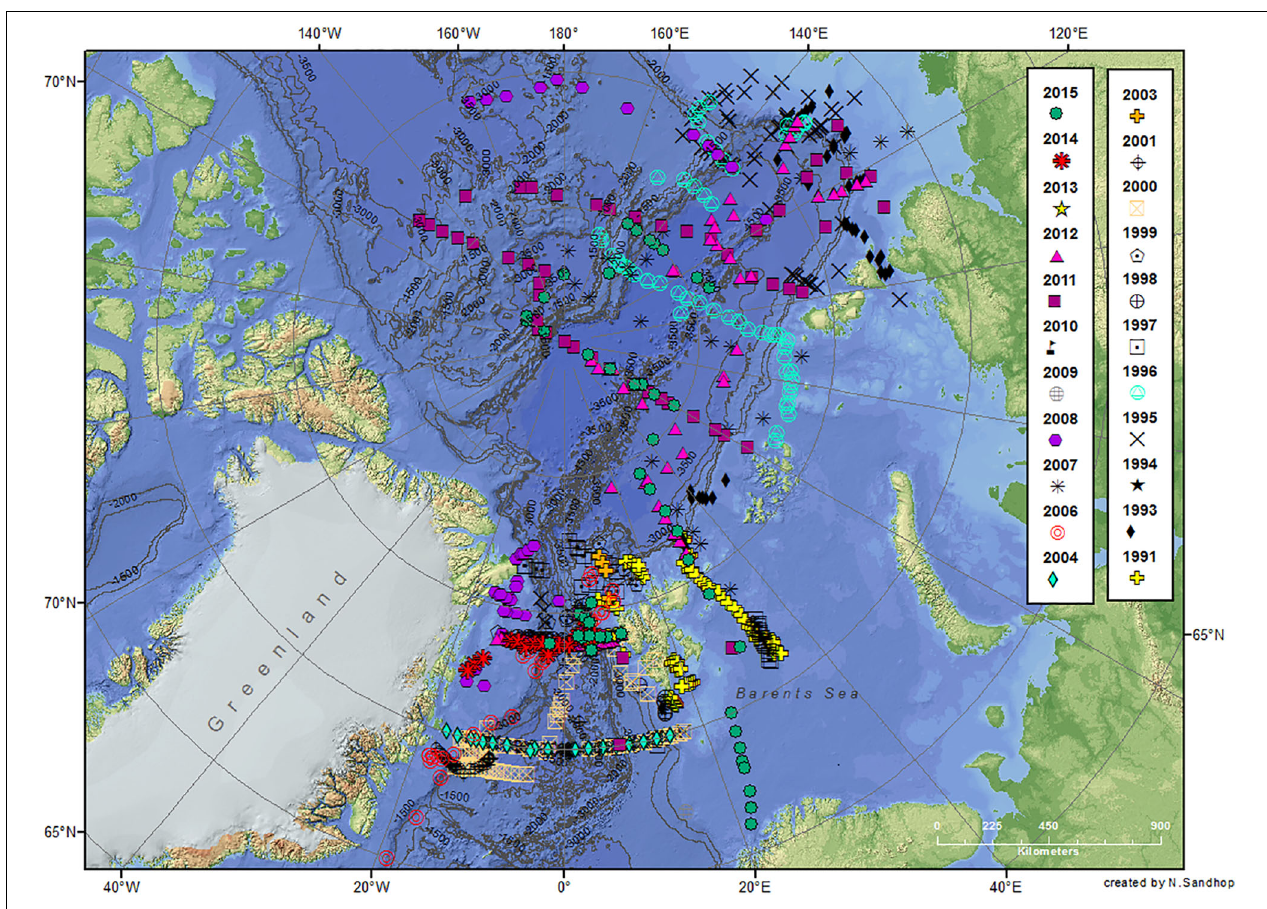
FIGURE 1 | Stations occupied during the different summer expeditions on board RVs Polarstern , Maria S Merian and Lance to the Arctic Ocean and the Fram Strait between the years 1991 and 2015. Details for each expedition can be found in the Supplementary Tables S1, S2 . The map was created using ArcGIS and based on the General Bathymetric Chart of the Oceans (GEBCO)-08 grid, version 20100927, http://www.gebco.net, with permission from the British Oceanographic Data Centre (BODC) with the help of Nadja Sandhop. More details can also be obtained by maps produced by AWI: https://maps.awi.de/map/map.html?cu=chl_a_water_